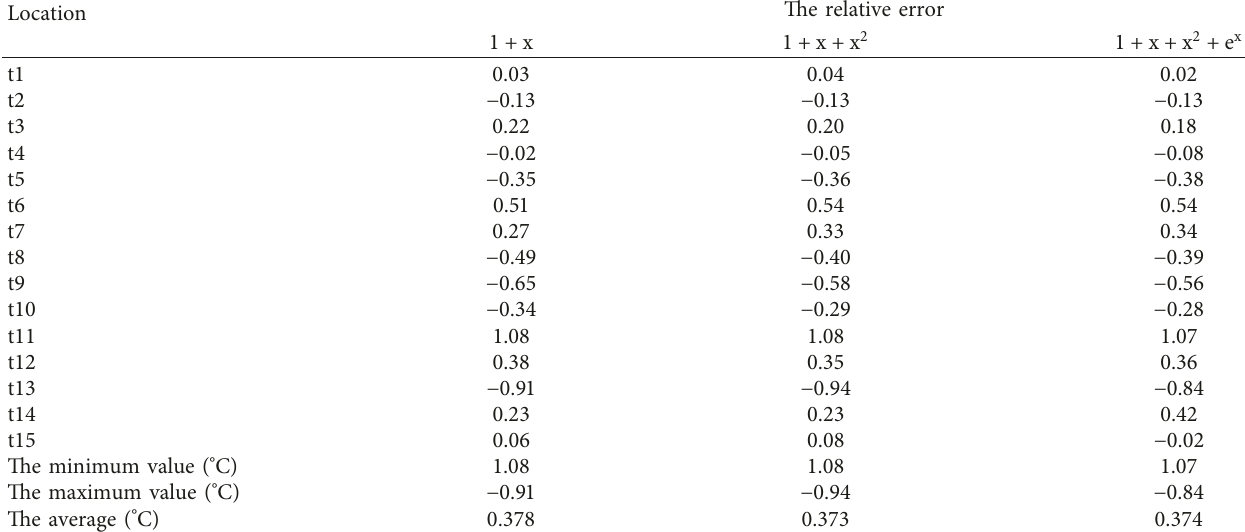
Table 2: Specific error data.